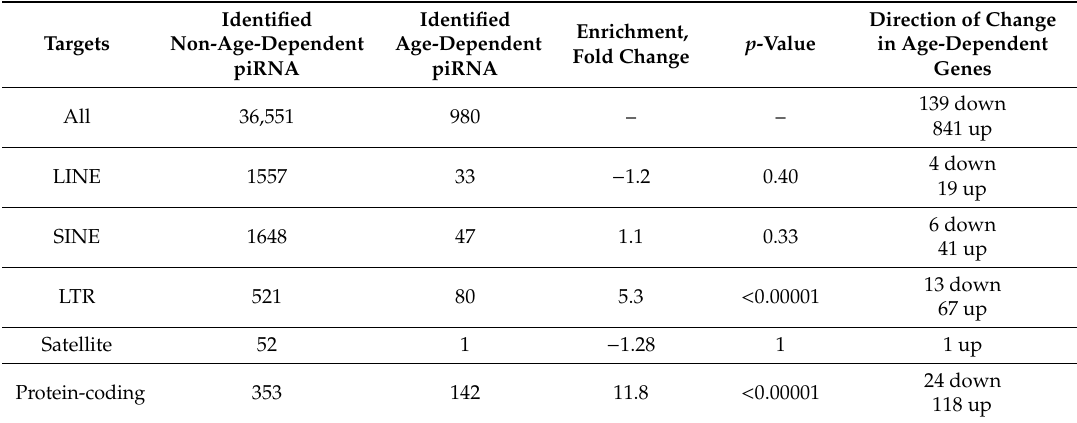
Table 2. Functional enrichment of significant age-dependent